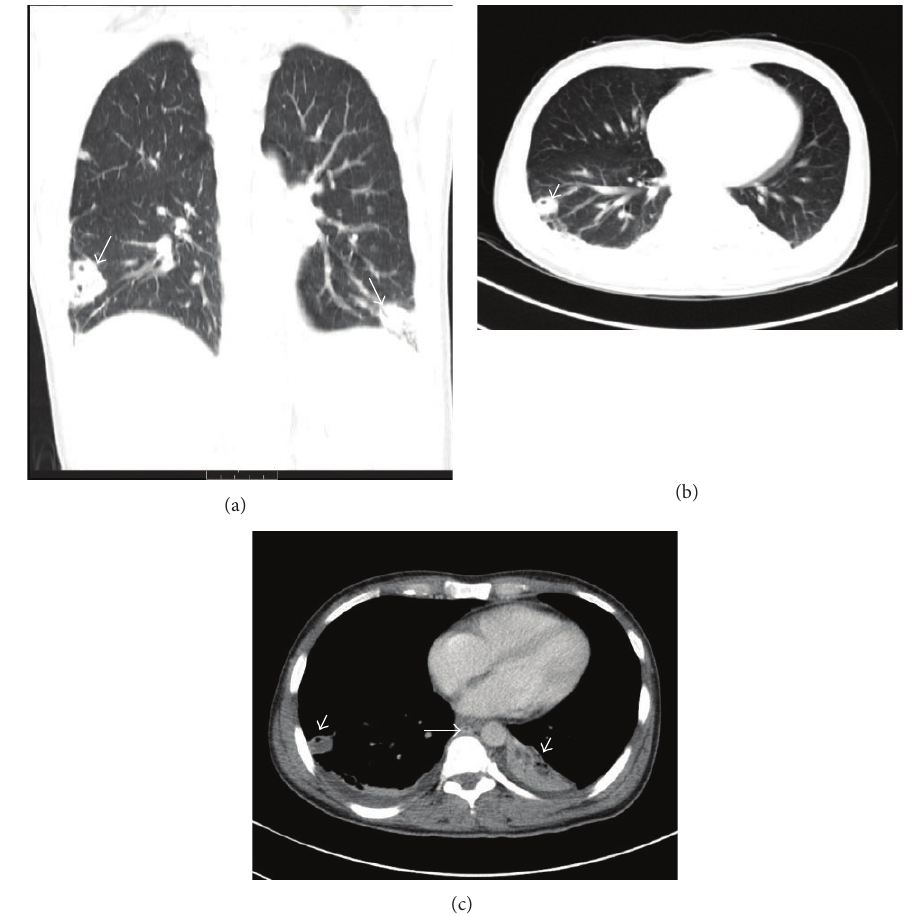
Figure 2: Computed tomography of the chest (panel (a): coronal view—lung window): multiple pulmonary cavitary lung lesions due to septic pulmonary emboli (arrows). Panel (b) (axial view—lung window) and panel (c) (axial view—mediastinal window) show multiple cavitary lung lesions due to septic pulmonary emboli (arrow heads). Filling defect is noted in the azygos vein suggestive of venous thrombus (arrow in panel (c)). There is associated mild pleural effusion